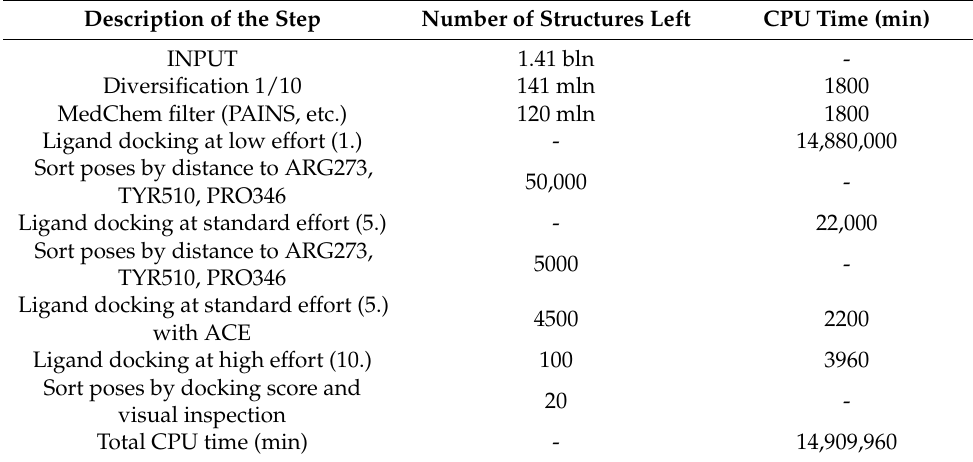
Table 3. Advanced roadmap RM2.